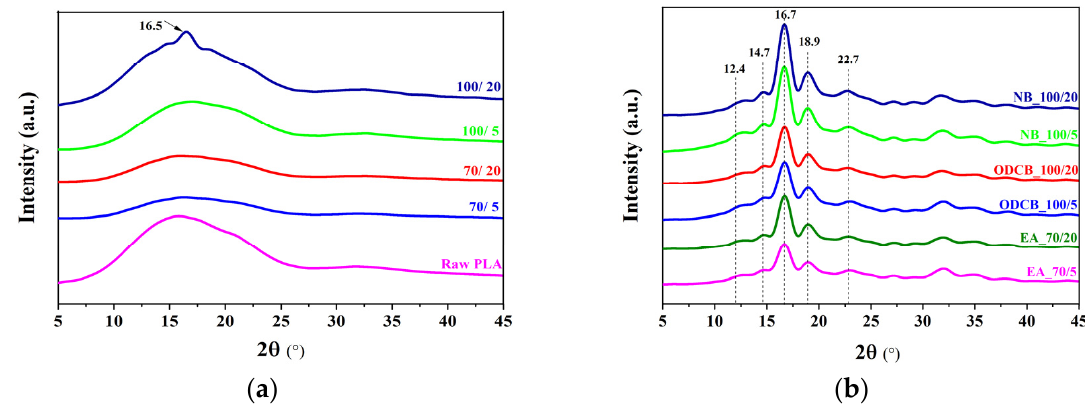
Figure 4. Wide-angle X-ray diffraction ( WAXD) pattern of raw and thermally-annealed PLLA at different treatment temperatures (70 and 100 °C) and times (5 and 20 min) ( a ); PLLA crystallized in solvents at different treatment temperatures (70 and 100 °C) and times (5 and 20 min) ( b ).